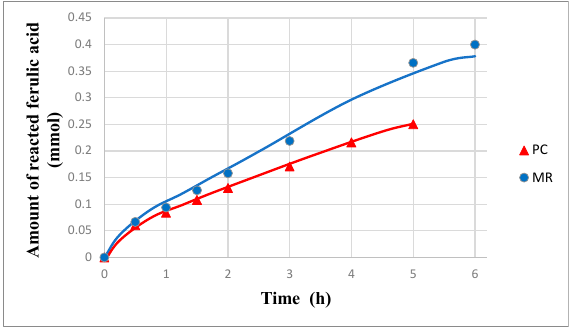
Figure 8. Amount of reacted ferulic acid (FA) vs. time in PC and in MR. Initial concentration of ferulic acid in Liquid 1 = 1 mM and (for the MR) initial concentration of ferulic acid in Liquid 2 = 1 mM.